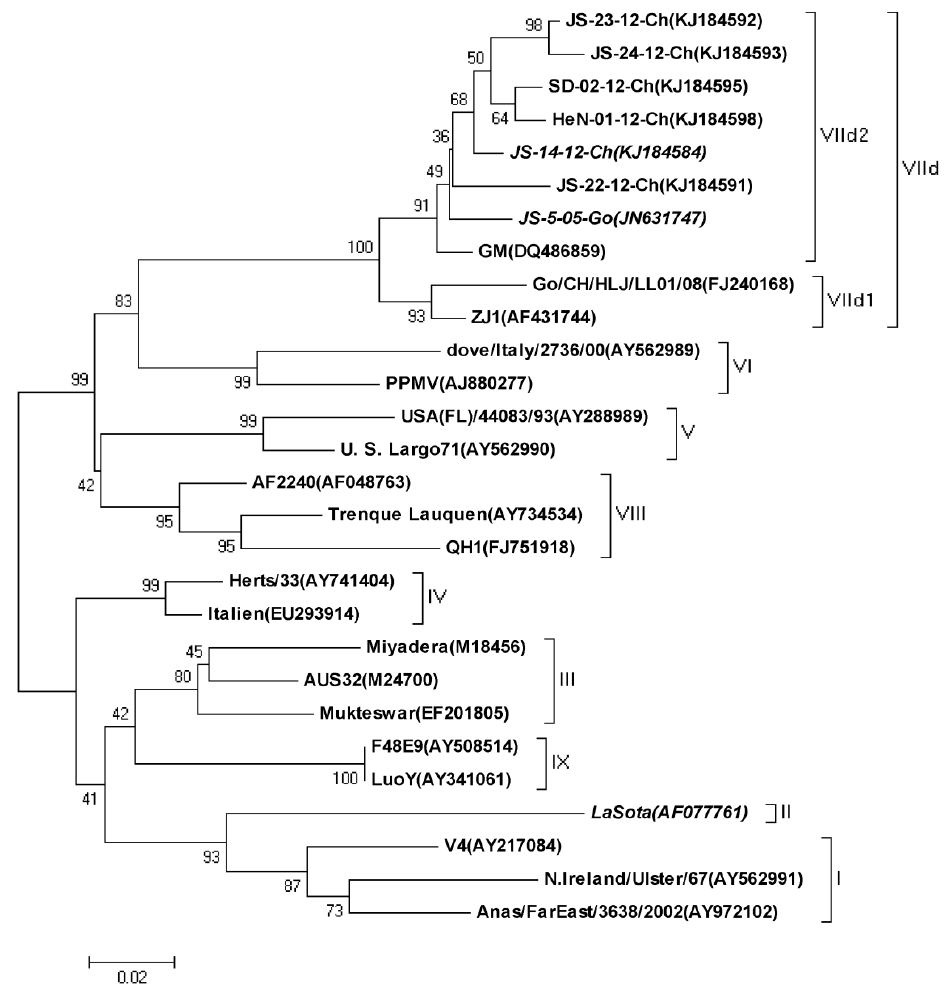
Figure 1. Phylogenetic analysis of the three Newcastle disease virus (NDV) strains based on the variable region of the F gene (nucleotides, 47-420).